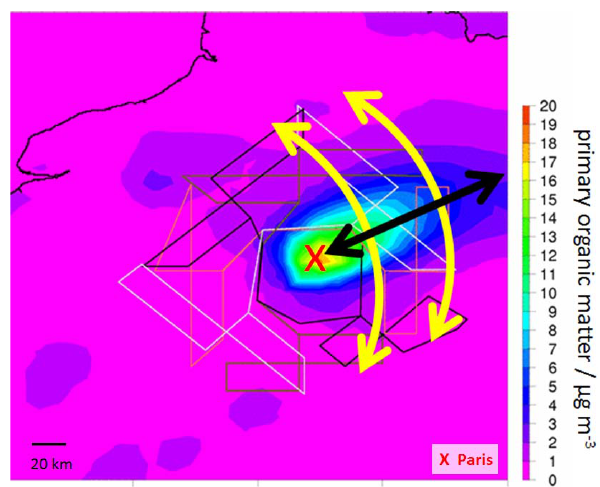
Fig. 2. Prev’Air Paris emission plume actual day forecast for 31 Jan- uary 2010 18:00:00UTC during the winter field campaign. The colour code indicates the concentration of primary organic matter, a marker for fresh air pollution. Paris is located in the middle of the straight black and grey lines (concentration colour code: yel- low/orange, red X), which indicate potential flight routes for the re- search aircraft. The yellow arrows demonstrate cross-section mea- surements of several ten to hundred kilometres at two different dis- tances to Paris. The black arrow indicates axial measurements start- ing at the outer areas of Paris up to about 200km away from the